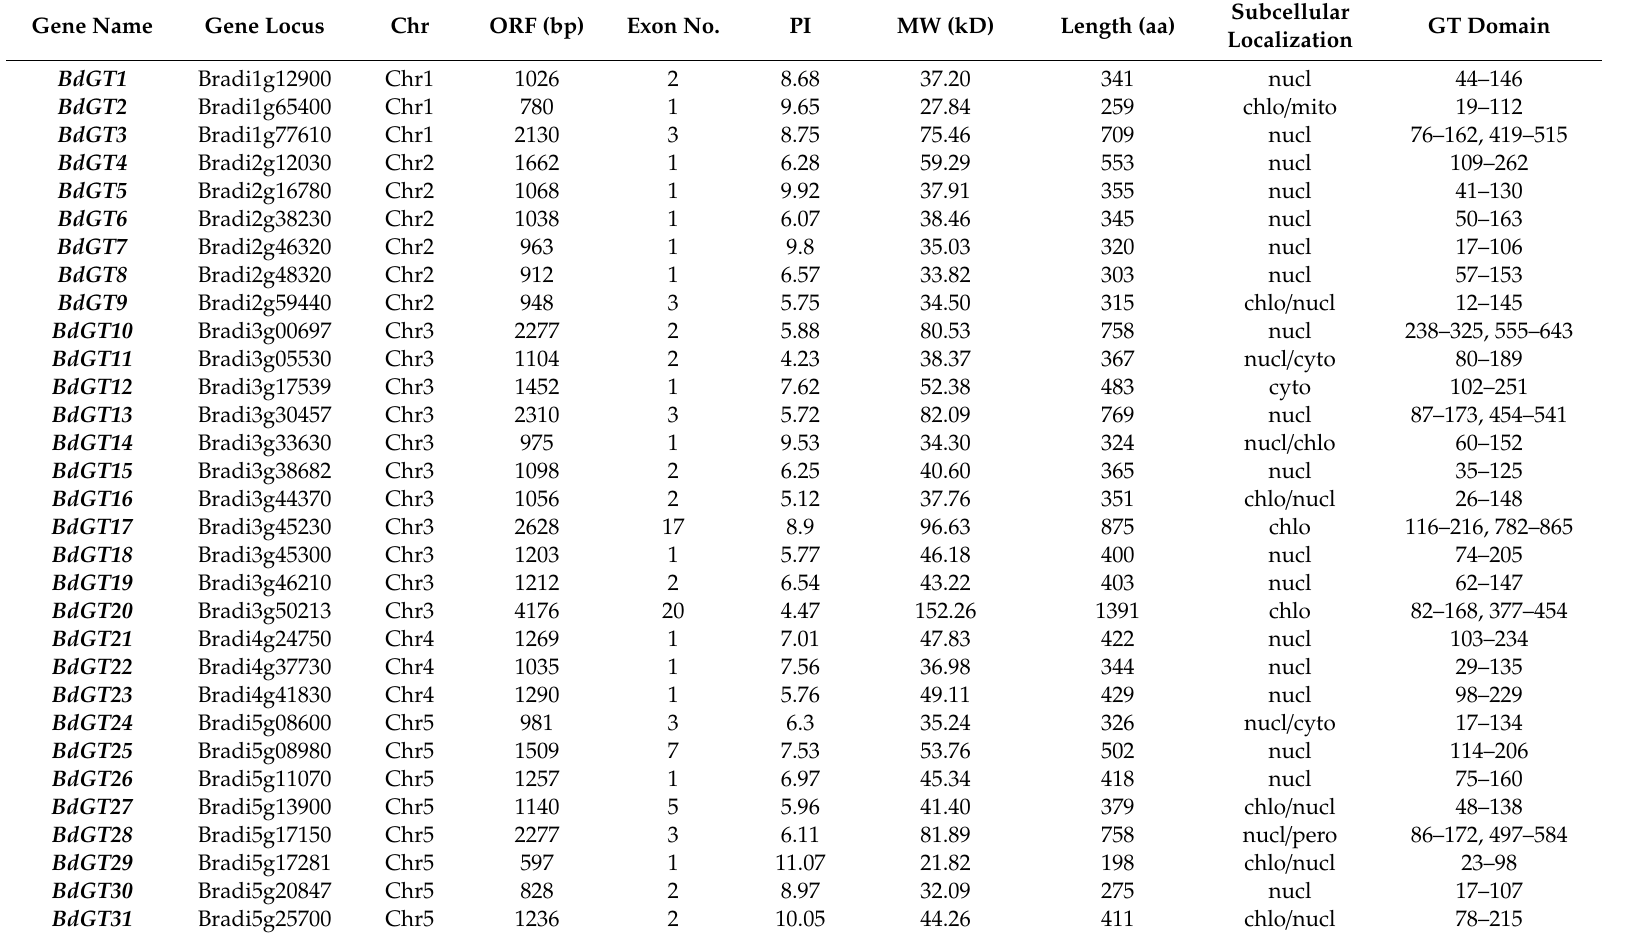
Table 1. GT factor family genes in B. distachyon